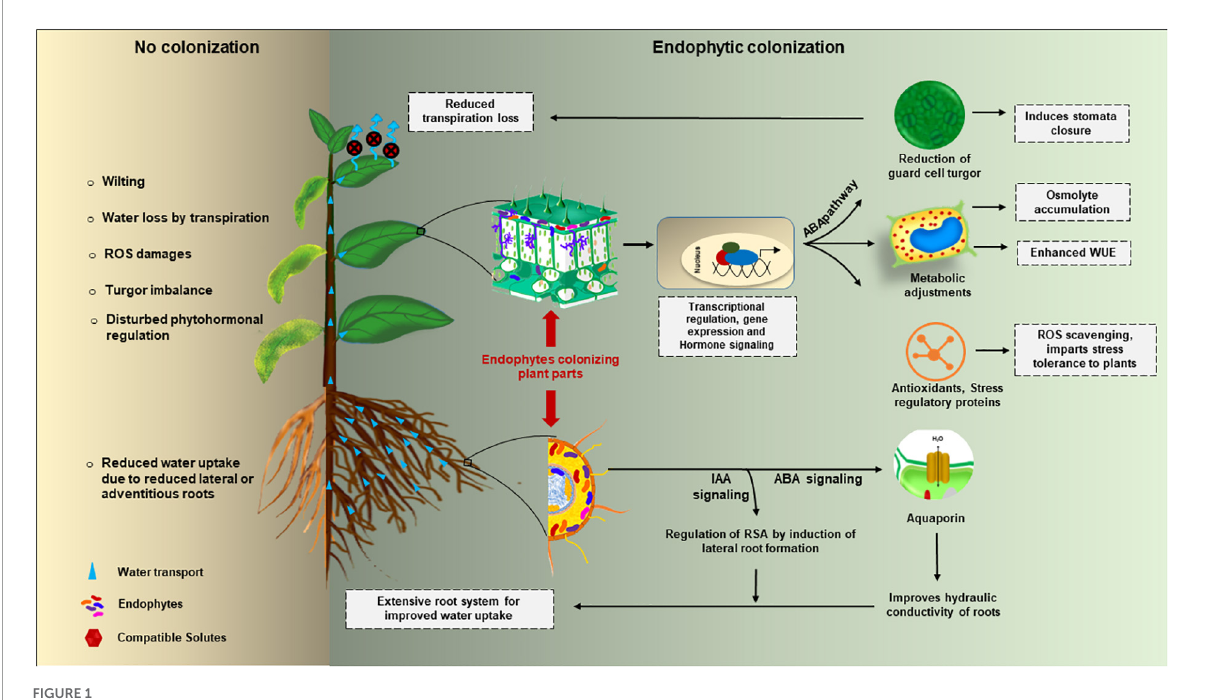
FIGURE1 Endophytic mediated cell-signaling during drought stress response in